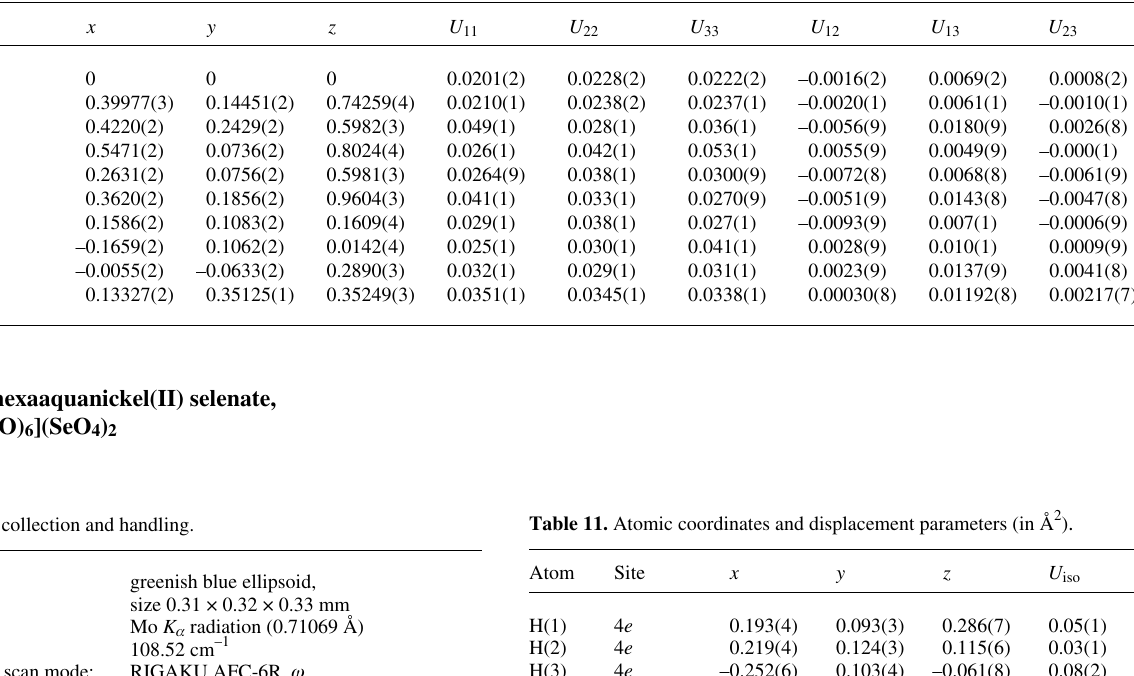
Table 9. Atomic coordinates and displacement parameters (in Å 2 ) .